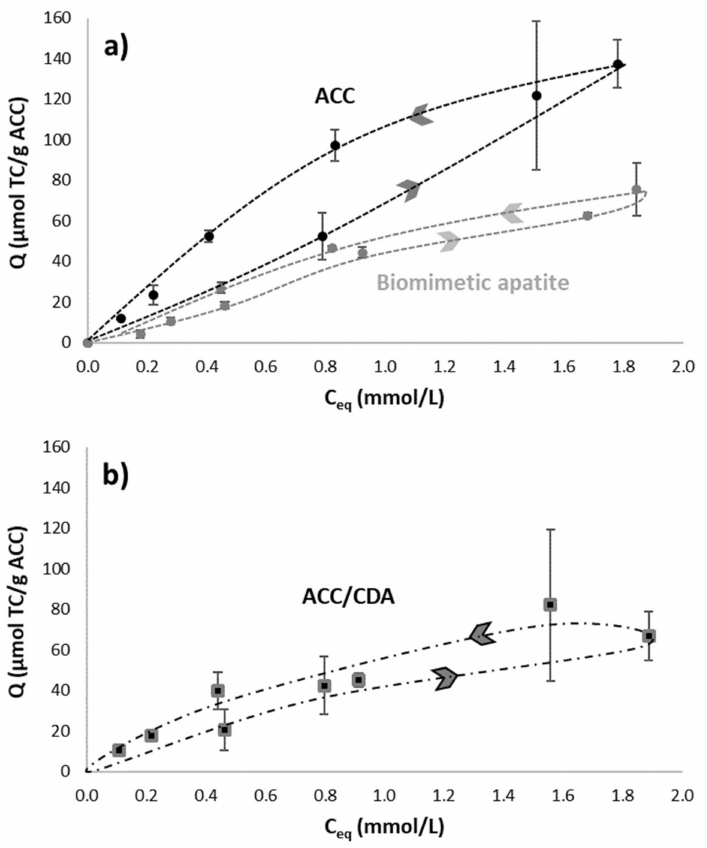
Figure 7. ( a ) Tetracycline adsorption-desorption isotherms on ACC materials (black dash line) and on biomimetic apatite powder (grey dash line). ( b ) Tetracycline adsorption-desorption isotherms on ACC/CDA